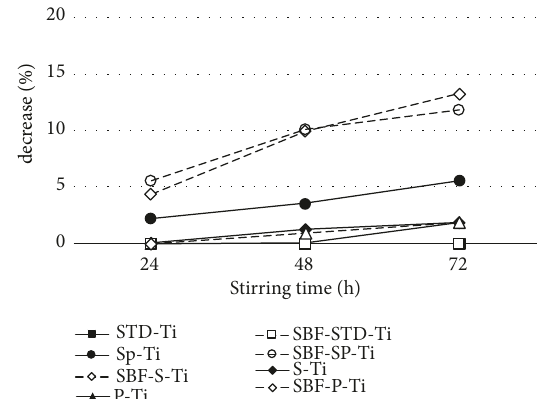
Figure 10: Changes in concentration of BSA when immersing Ti samples in BSA aqueous